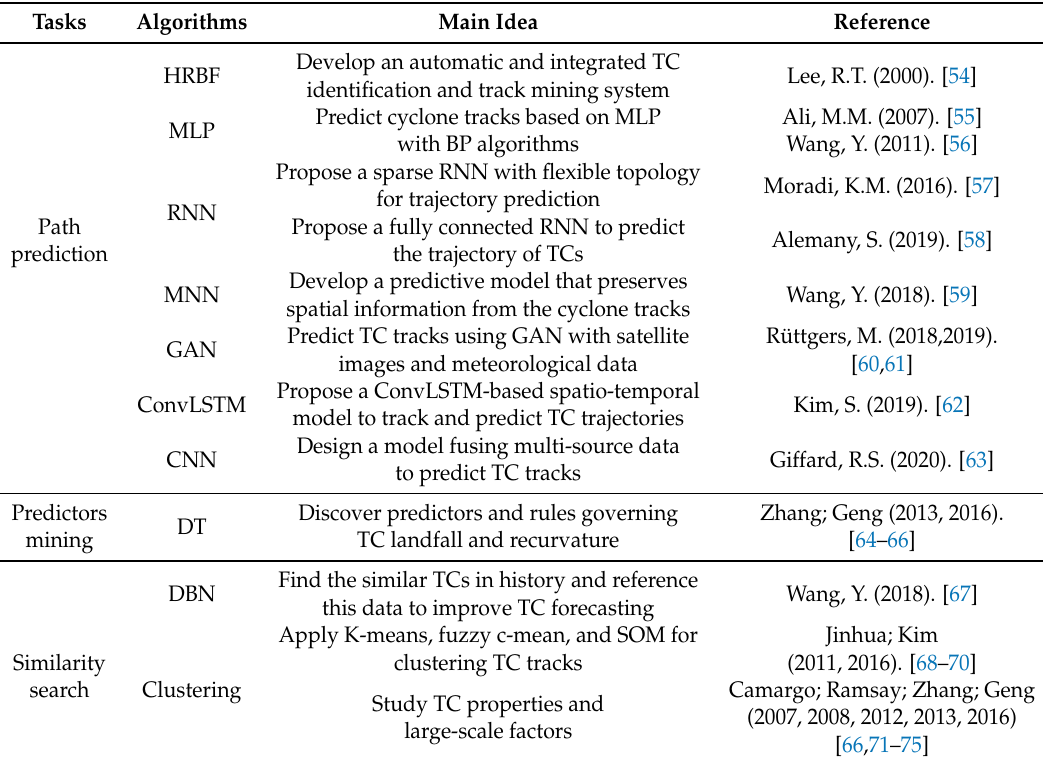
Table 2. Machine learning in TC track